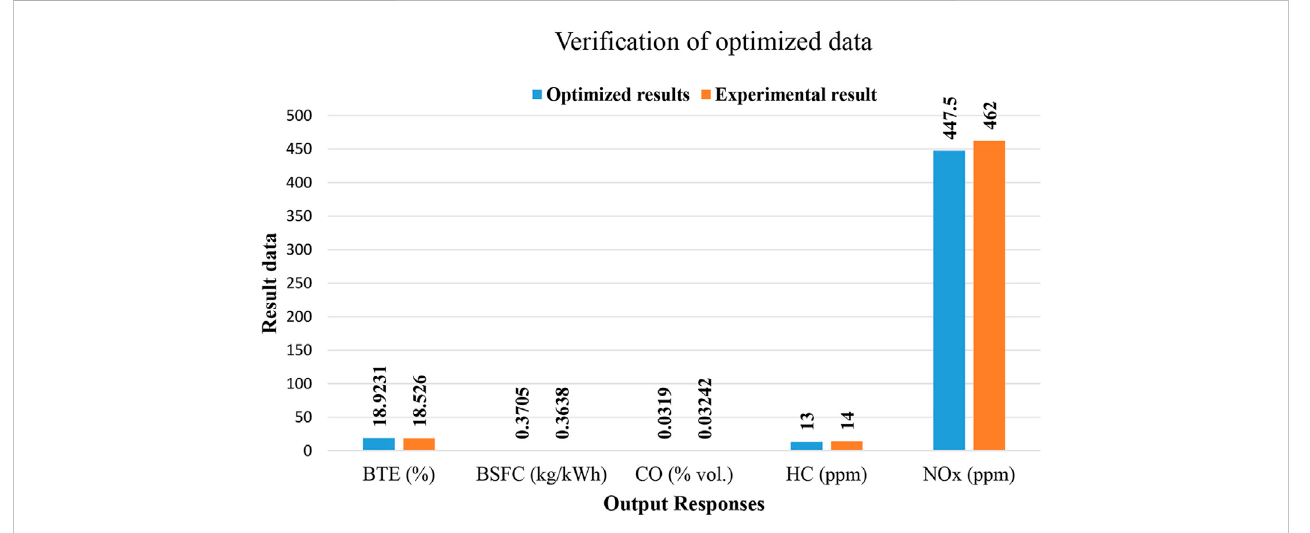
FIGURE 10 The validation of optimized results experimentally. 20% SOME ratio, 577.5 bar FIP, 5.26% EGR rates, and 5.12 kg engine load.